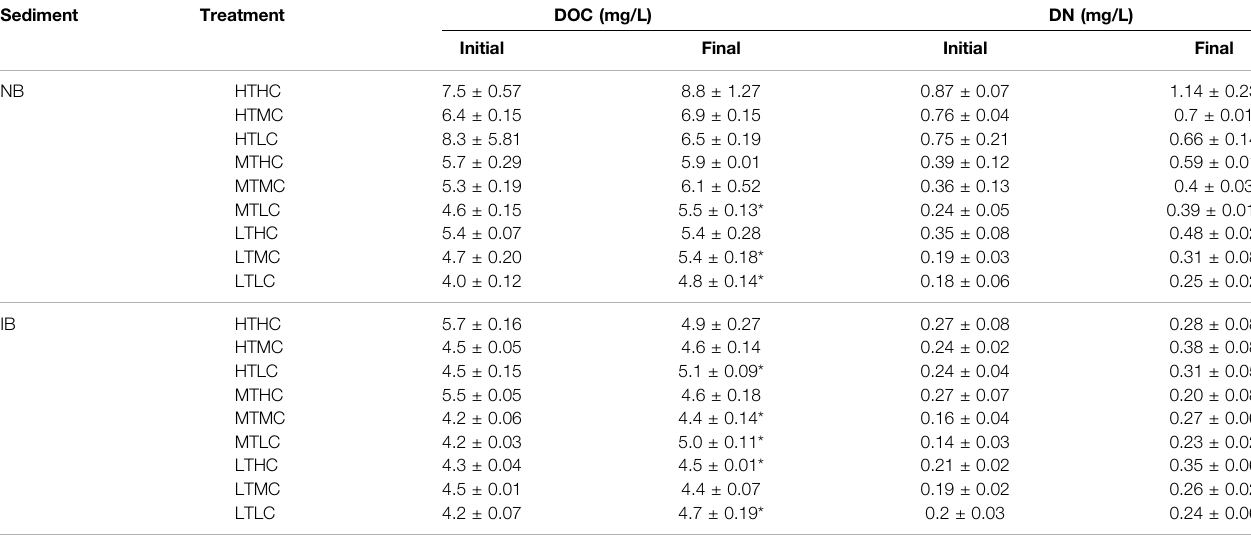
TABLE 5 | Dissolved organic carbon (DOC) and dissolved nitrogen (DN) by sediment type (NB and IB) and treatment at the beginning and end of the experiments. Sediment Treatment